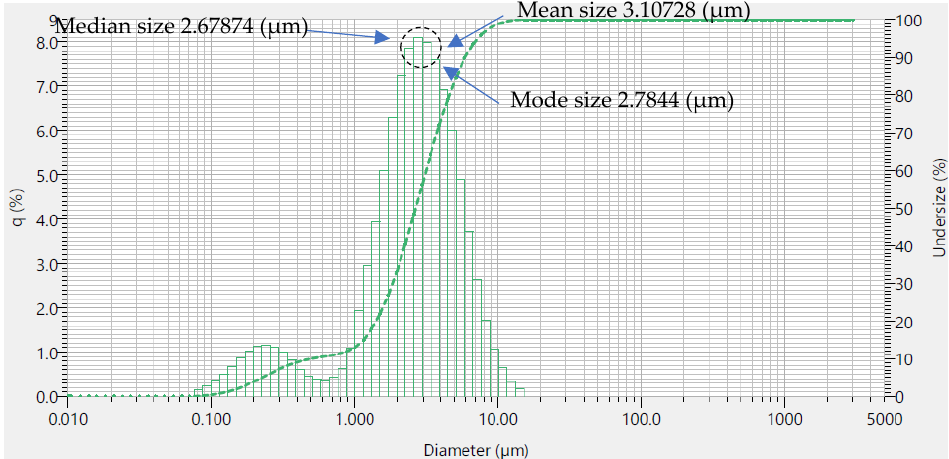
Figure 5. Statistical results of the Laser Scattering Particle Size Distribution Analyzer Partica LA-960 that shows the particle sizes according to ISO 13320:2009.